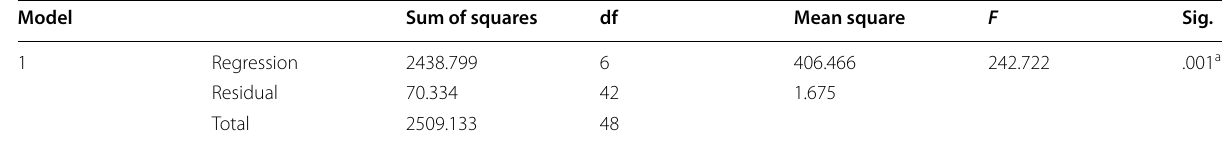
Table 7 ANOVA of the regression model for decomposition rate